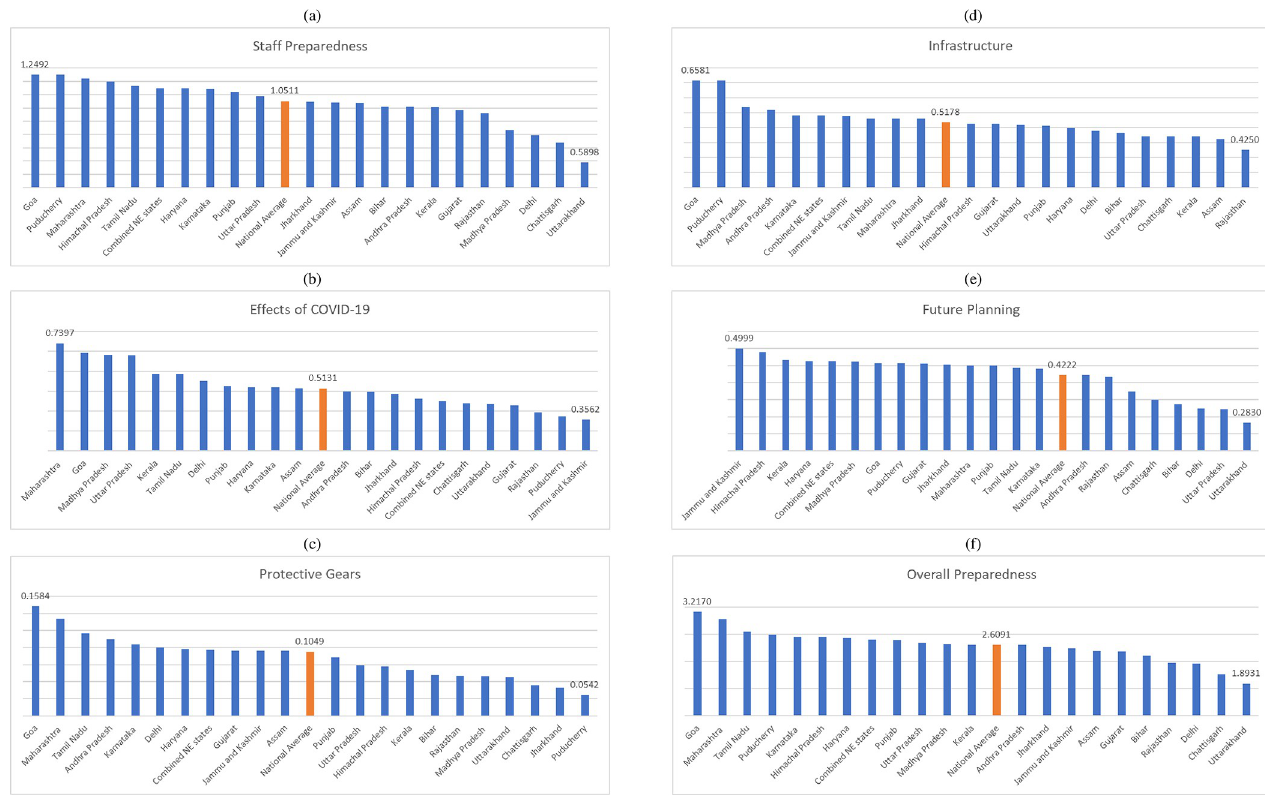
Fig 1. State-level comparisons of COVID-19 preparedness as per weighted negative log likelihood scores of the staff and hospital preparedness index. The national average is highlighted. (a): domain 1, staff preparedness; (b) domain 2, effects of COVID-19; (c) domain 3, protective gears; (d) domain 4, infrastructure; (e) domain 5, future planning, and; (f) overall